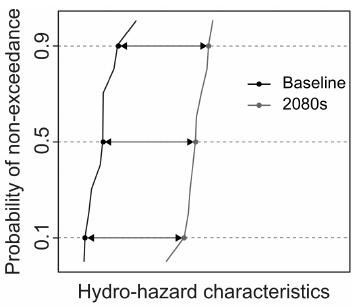
Figure 2. Quantification of signal of change in a hydro-hazard char- acteristic, as the difference between the baseline and 2080s cumu- lative distribution functions for the 10th, 50th, and 90th percentiles (dotted